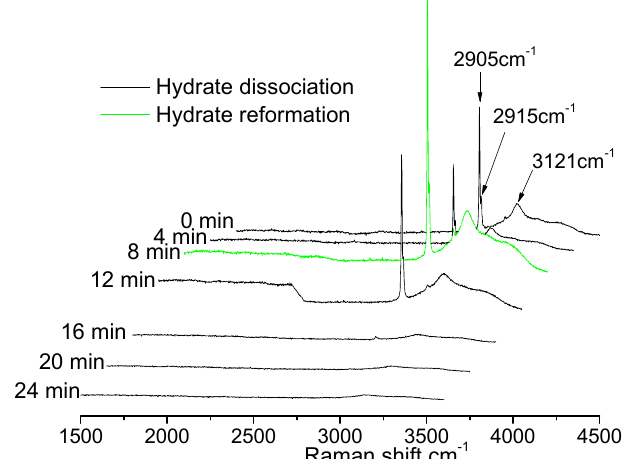
Figure 3. Methane hydrate decomposition at 263 K and atmospheric pressure.